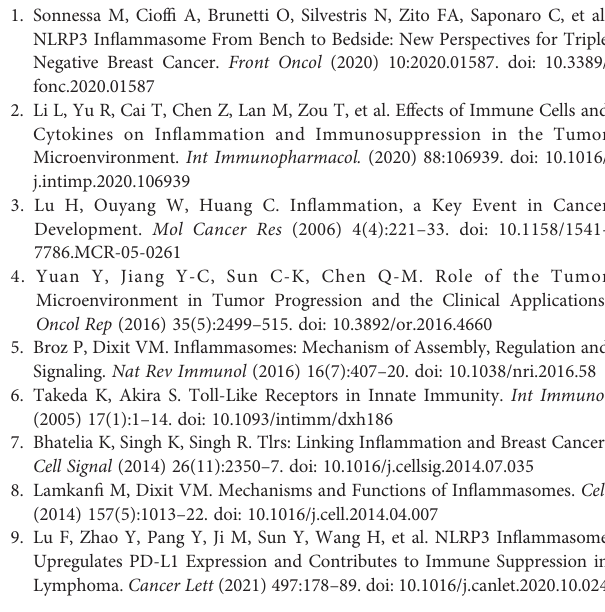
Bold values indicate signi fi cance. HR, Hazard-ratio; NLRP3, NOD-like receptor protein 3; PYCARD, Apoptosis-Associated Speck-Like Protein Containing a Pyrin and CARD domain; TLR4, Toll-like receptor